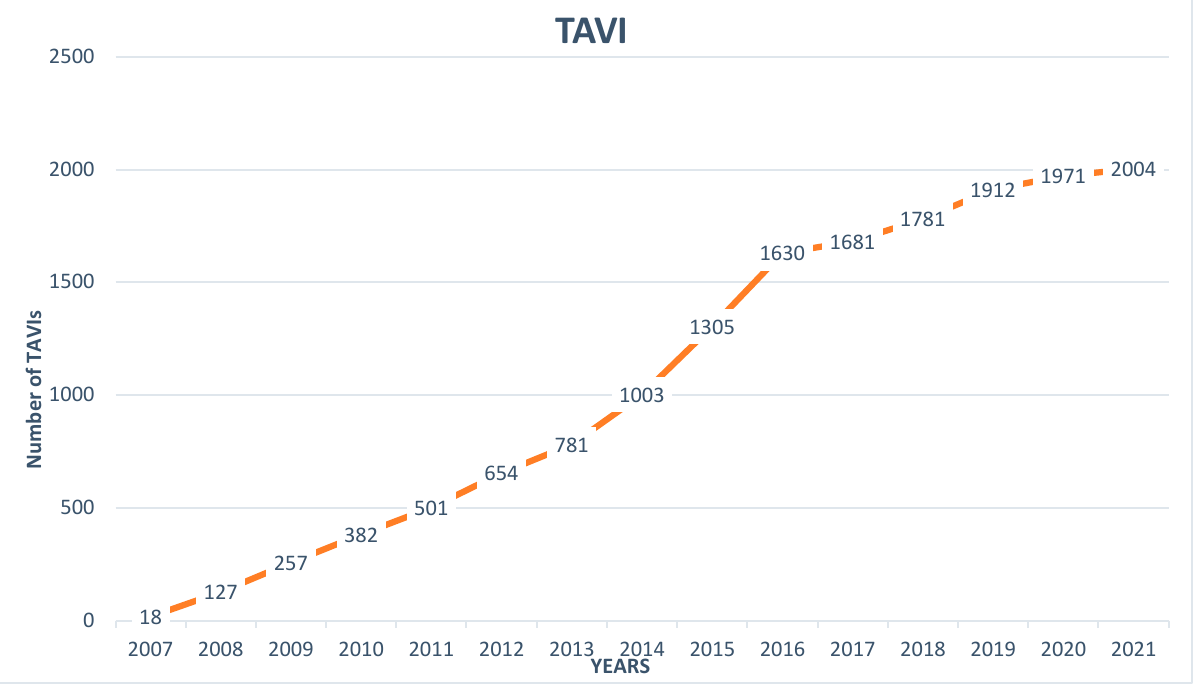
Figure 5. Trends in transcatheter aortic valve implantations in Switzerland from its introduction in 2007 to 2021.